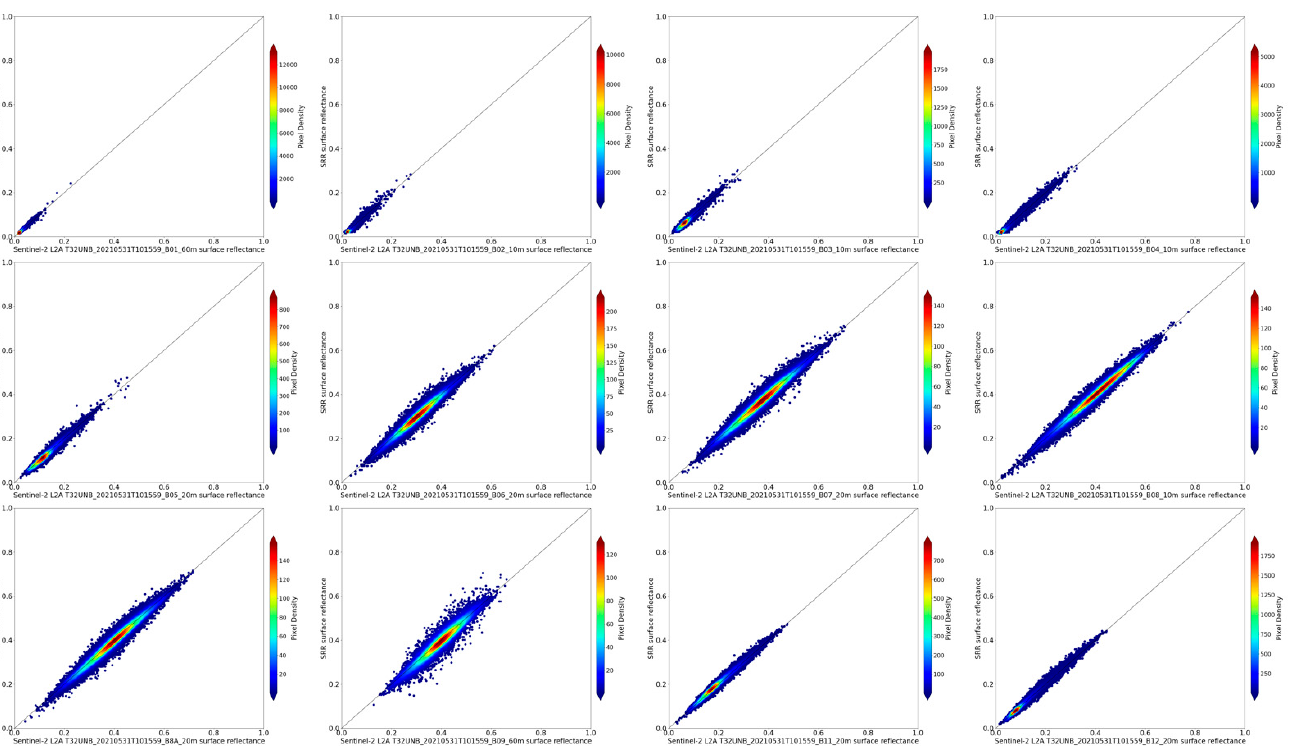
Figure 16. Site-3 intercomparisons of all spectral bands of the SRR product against the original Sentinel-2 L2A surface reflectance product (S2B_MSIL2A_20210531T101559_N0300_R065_T32UNB_20210531T140040).